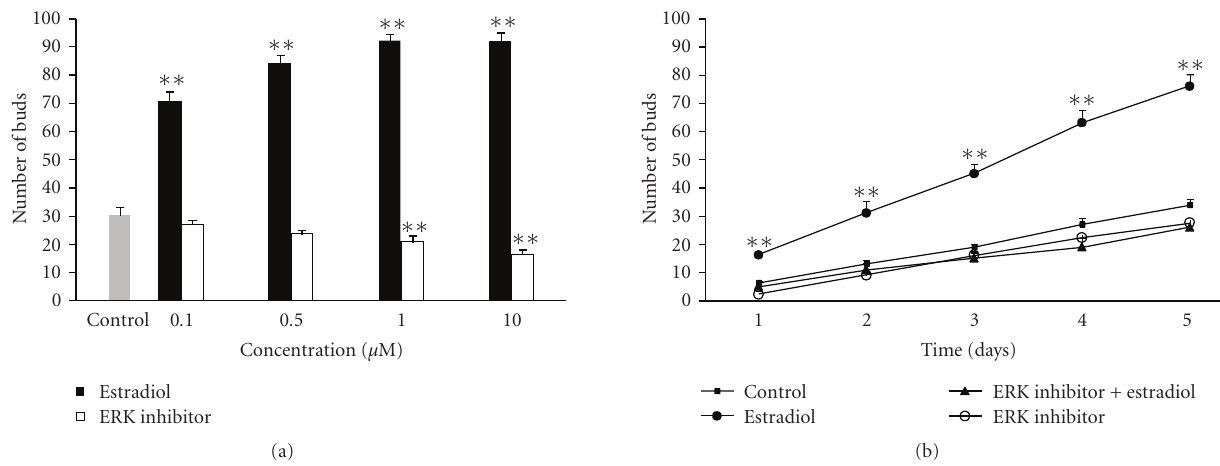
Figure 1: Concentration-response and response-time curves. 17 β -estradiol augments the number of buds in Taenia crassiceps under physiologic concentrations (0.1 μ M). Specific inhibition of ERK blocks the 17 β -estradiol e ff ect on the parasite, resulting in a similar number of buds between control and ERK inhibitor-treated cysticerci; (a) 17 β -estradiol e ff ect was progressively increasing during the five days of in vitro culture, whereas ERK inhibitor 0.5 μ M did not modify parasite reproduction when compared to control cysticerci, even in presence of 17 β -estradiol 0.1 μ M, and (b) Control = Parasites treated with the vehicle where hormone and inhibitors were dissolved; ∗∗ P < . 05.